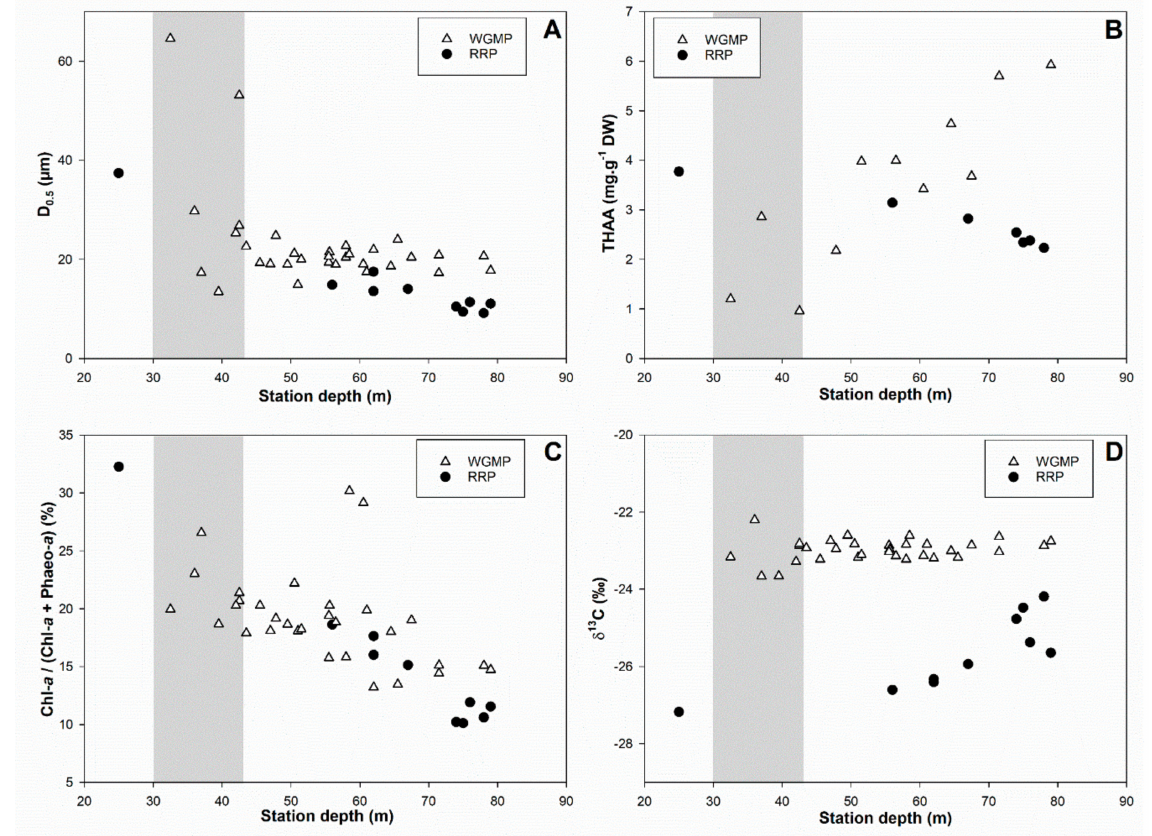
Figure 10. Relationships between station depth and main surface sediment characteristics in the WGMP and the Rh ô ne River Prodelta (RRP): D 0.5 ( A ), Total Hydrolyzable Amino Acids (THAA ( B )), Chl- a /(Chl- a +Phaeo- a ) ratio ( C ), and δ 13 C ( D ). Gray areas represent the proximal part of the WGMP (z < 42.5